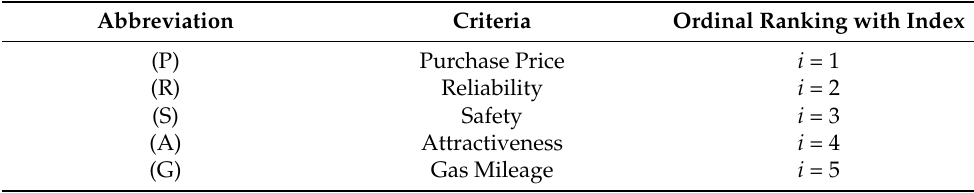
Table 12. Ordinal criteria